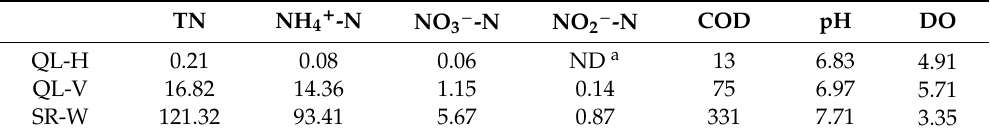
Table 1. General physicochemical parameters of three environmental waters of the pristine Qingshan Lake and its branch, the Sewage